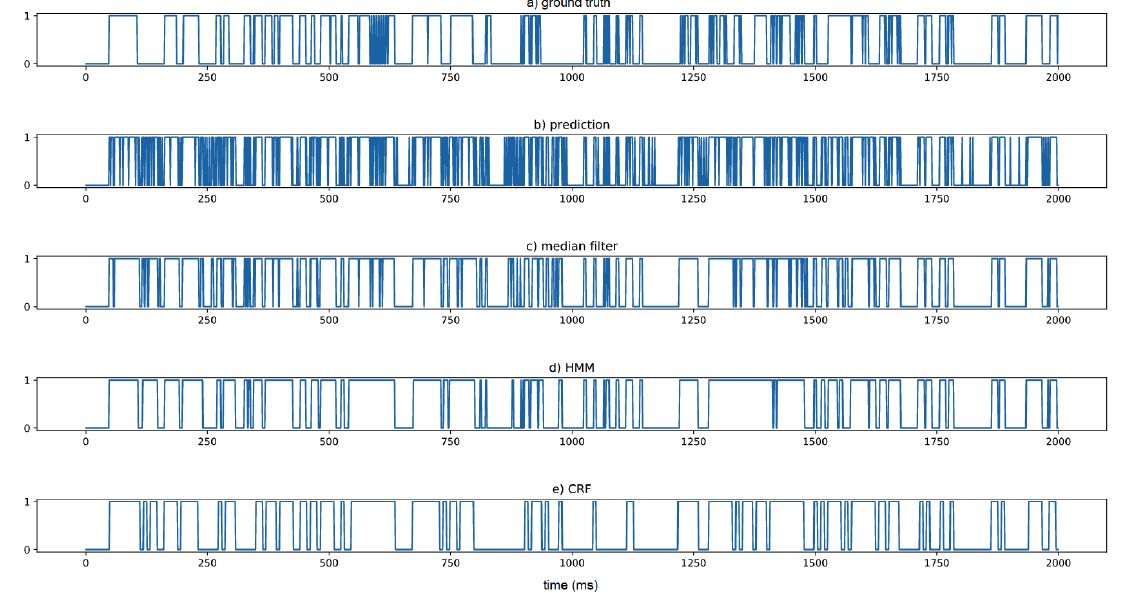
Figure 17. Segments with different postprocessing methods of temporal smoothing: ( a ) ground truth, ( b ) prediction segments, ( c ) median filter, ( d ) HMM, ( e ) CRF.